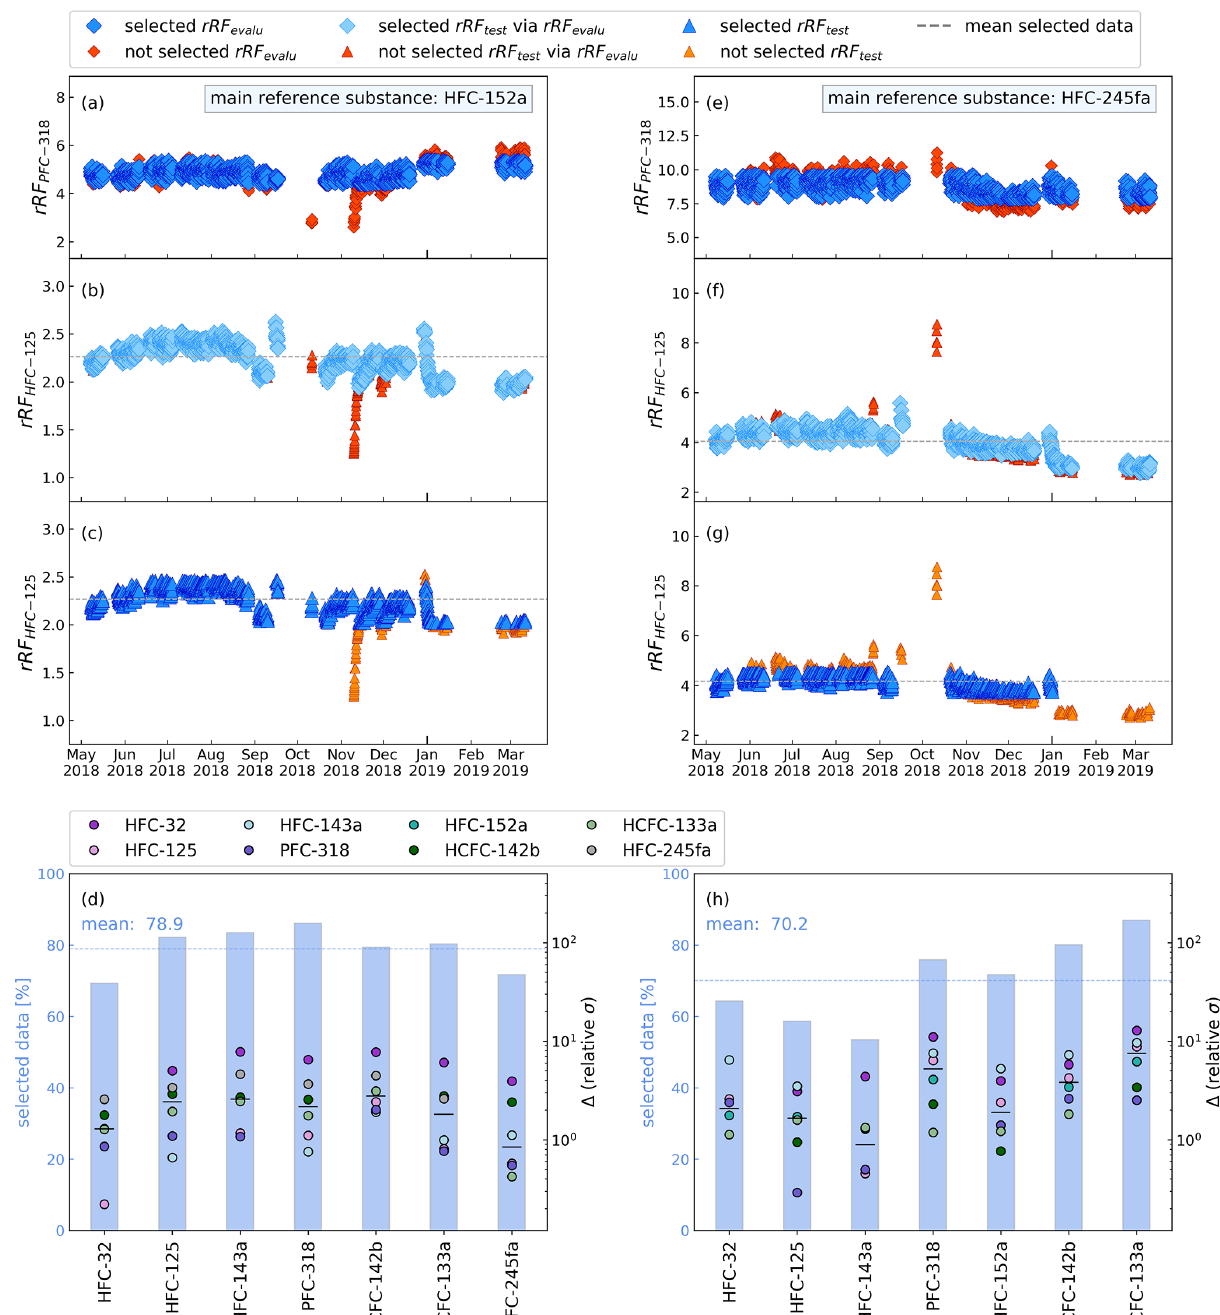
Figure 7. Same as Fig. 5 but for the continuous in situ measurements at Taunus Observatory using main reference substances HFC-152a (a–d) and HFC-245fa (e–h) and PFC-318 as evaluation